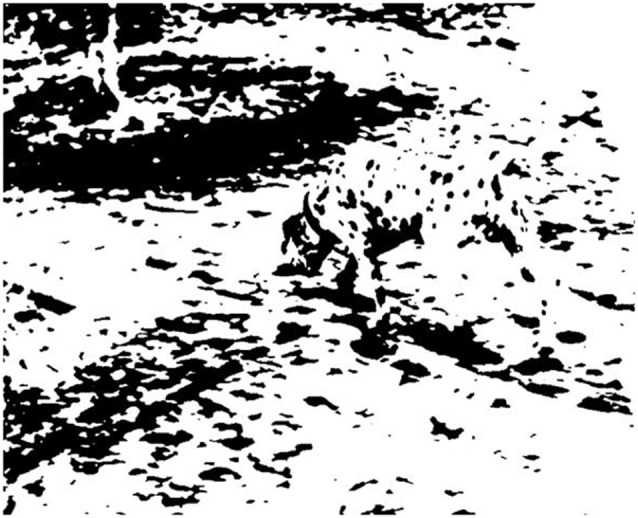
First appeared in Gregory (1970).